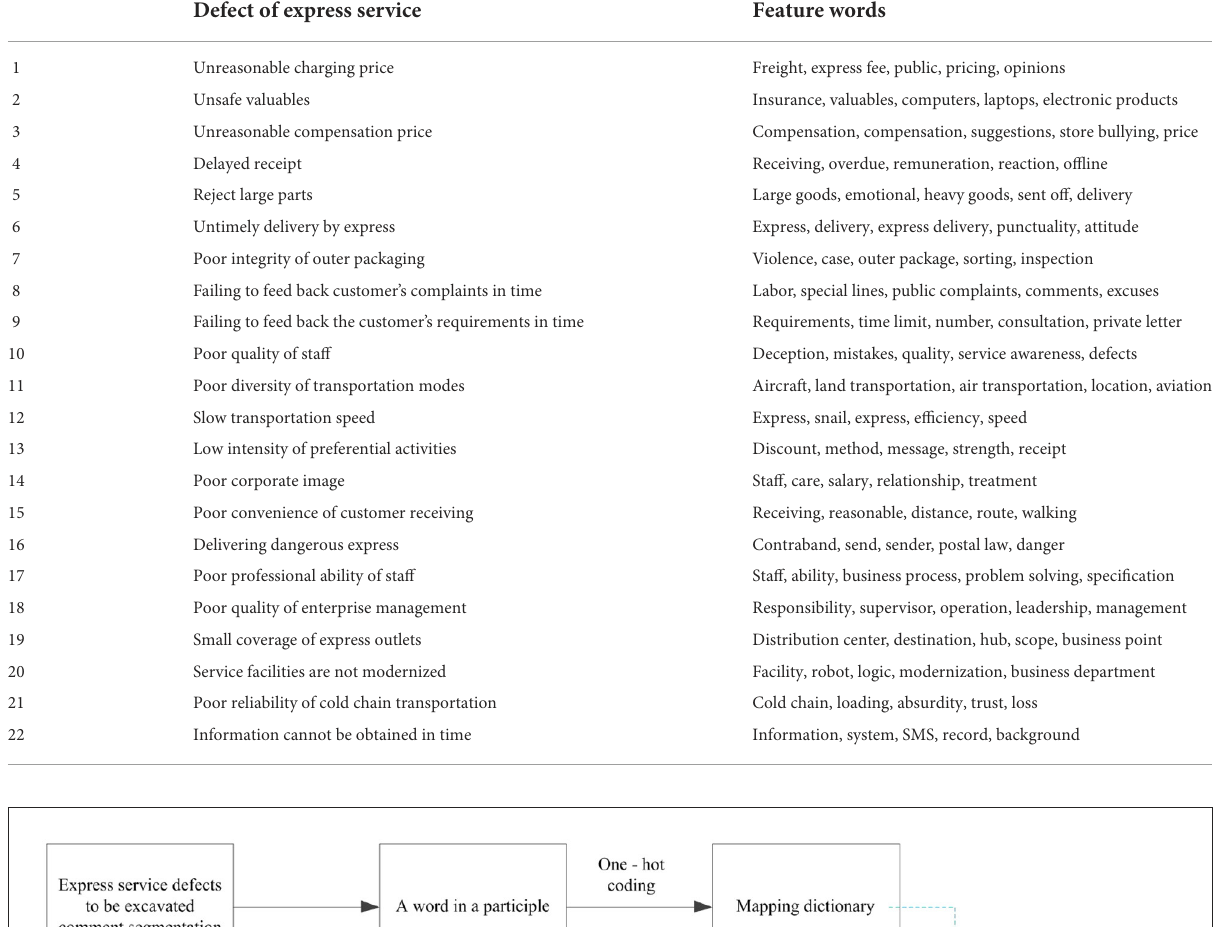
TABLE 3 22 topics of defect of express service.